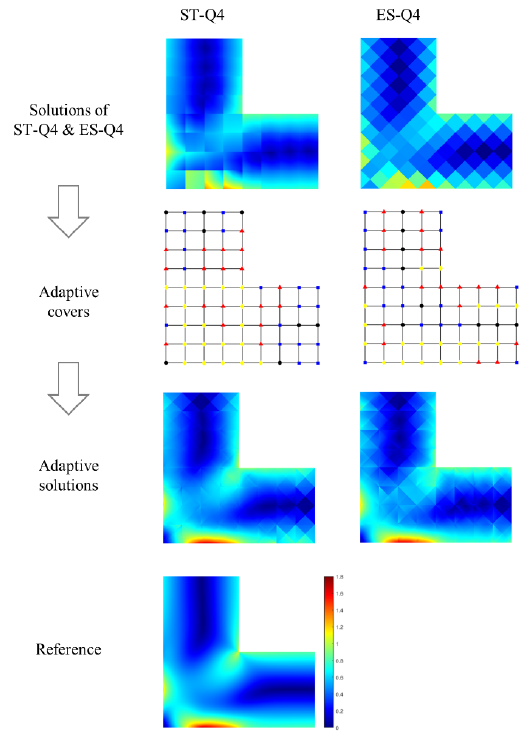
Figure 13. Automotive wheel problem: ( a ) Problem description. ( b ) Sequence of meshes (Mesh I, II, and III) used.